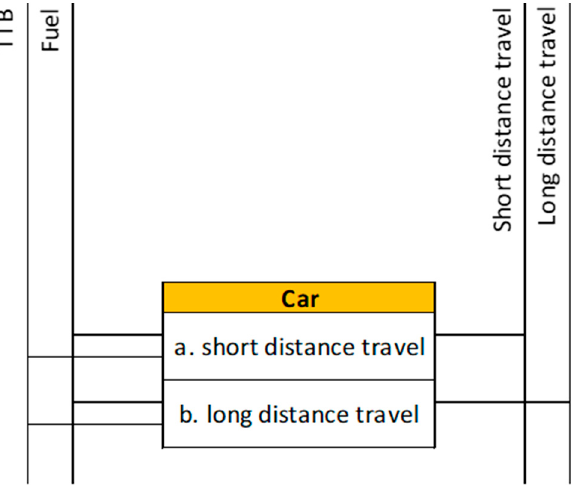
Figure 3. A principal diagram of modeling a car in the energy planning model. Fuel economy FE y , f , a , d is calculated by dividing the vehicle occupancy rate OR y by its fuel consumption rate FCR y , f , a , d and multiplying it by 100. Here, the fuel economy is measured in Mpkm per 1 kt of fuel and fuel consumption rate in kg/100 km, while average vehicle occupancy rate is in persons.